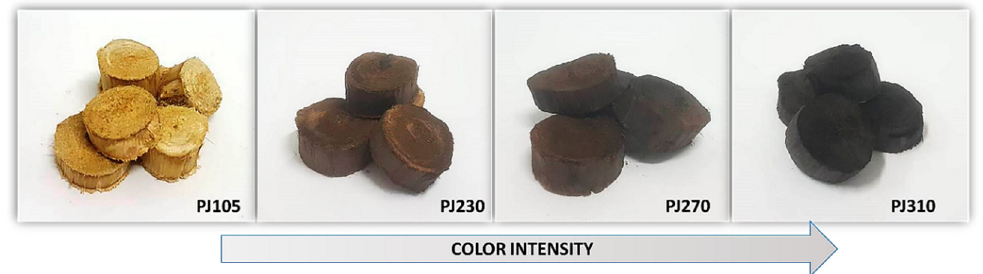
Figure 2. Biomass of P. juliflora before and after torrefaction.